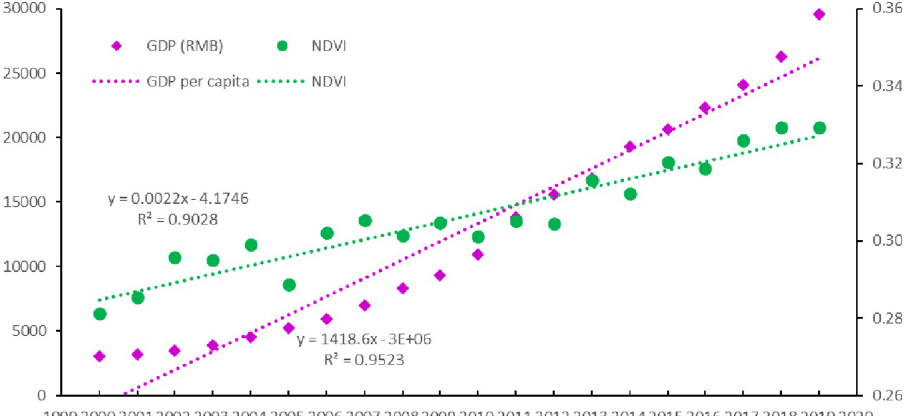
Fig 6. Change trends of NDVI and GDP in the fourteen contiguous areas of dire poverty from 2000 to